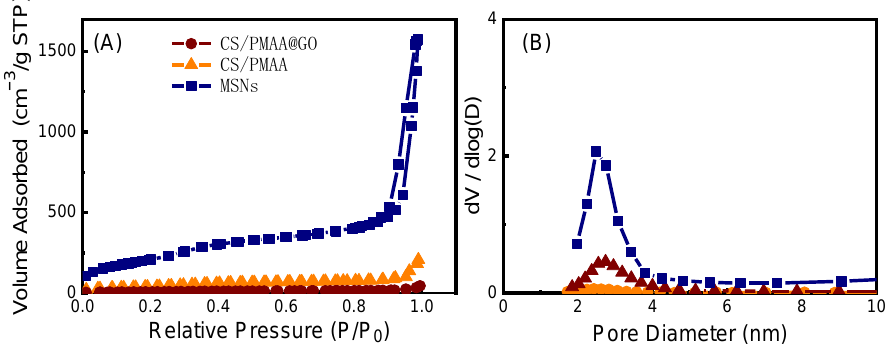
Figure 7. GO, TA, MSNs, MSN loading TA, CS/PAMAA-MSNs@GO, and CS/PMAA-MSNs@GO loading TA under air atmosphere heated from 30 to 800 °C.